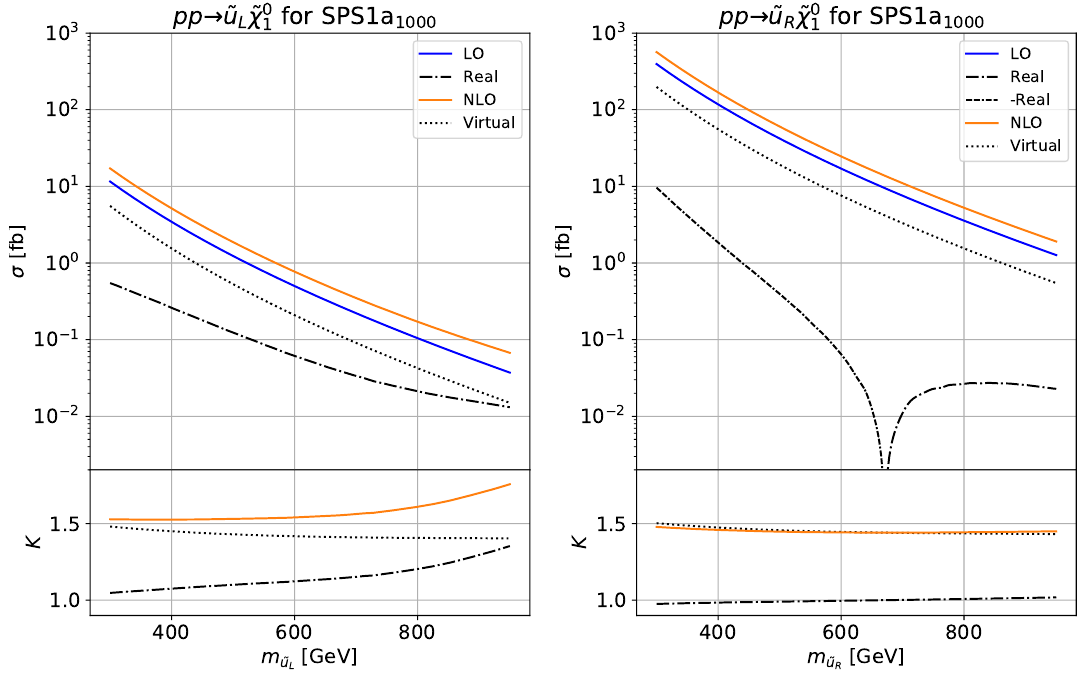
Figure 2. NLO cross sections σ ( pp → ˜ u L,R ˜ χ 0 ) and their virtual and real components (top panels) 1 as well as the associated K factors (bottom panels) as a function of the physical squark mass m ˜ u for a fixed mass difference m ˜ u − m ˜ u = 20 GeV . This fixed mass difference is only adopted in L R order to reproduce ref. [19], even though it breaks in general SU(2) L invariance. The remaining MSSM parameters are fixed to the benchmark point SPS1a 1000 , the LHC energy is and CTEQ6.6M PDFs are employed.